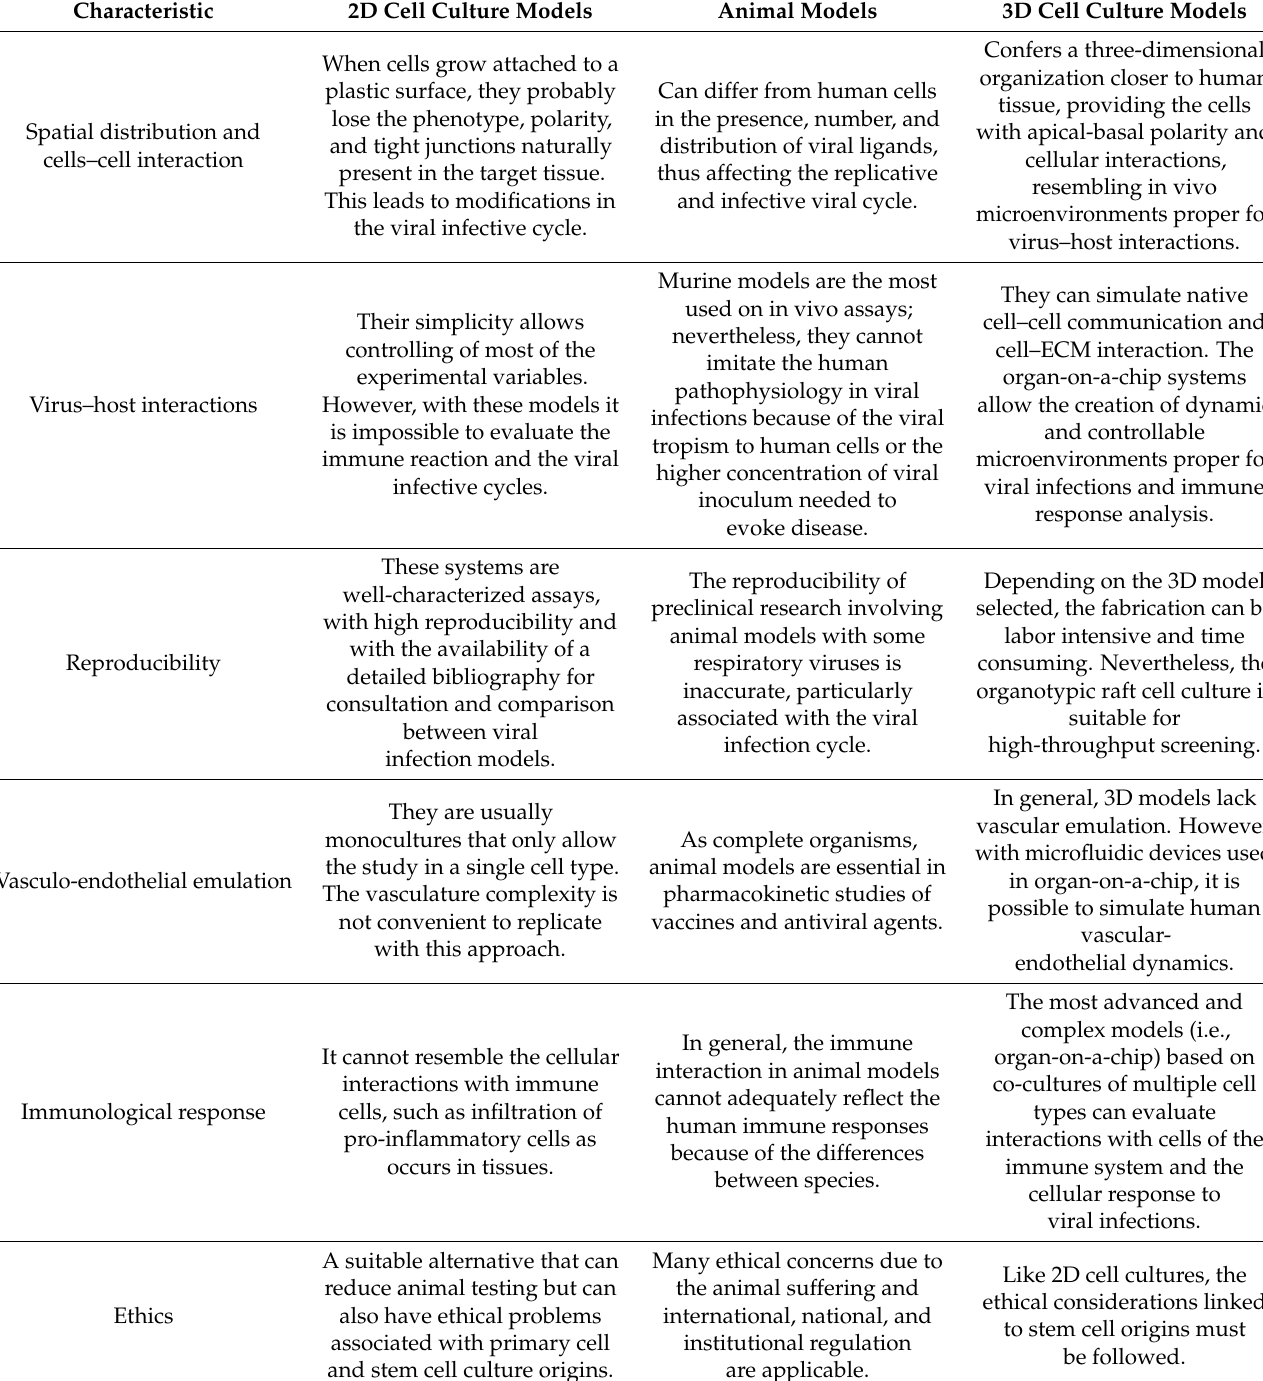
Table 1. Comparison of 2D and 3D cell cultures and animal models in viral infection